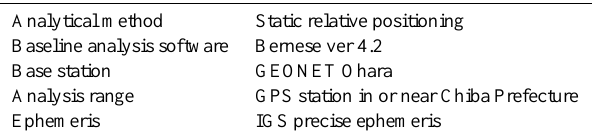
Table 1. GPS analysis conditions.